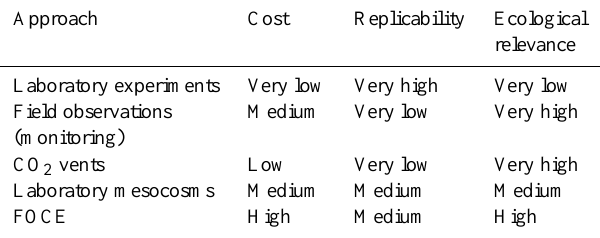
Table 6. Benefits and limitations of the five main approaches used to investigate the effects of ocean acidification. A five-stage rank- ing is used: very high, high, medium, low, and very low. Modeling approaches are not considered in this